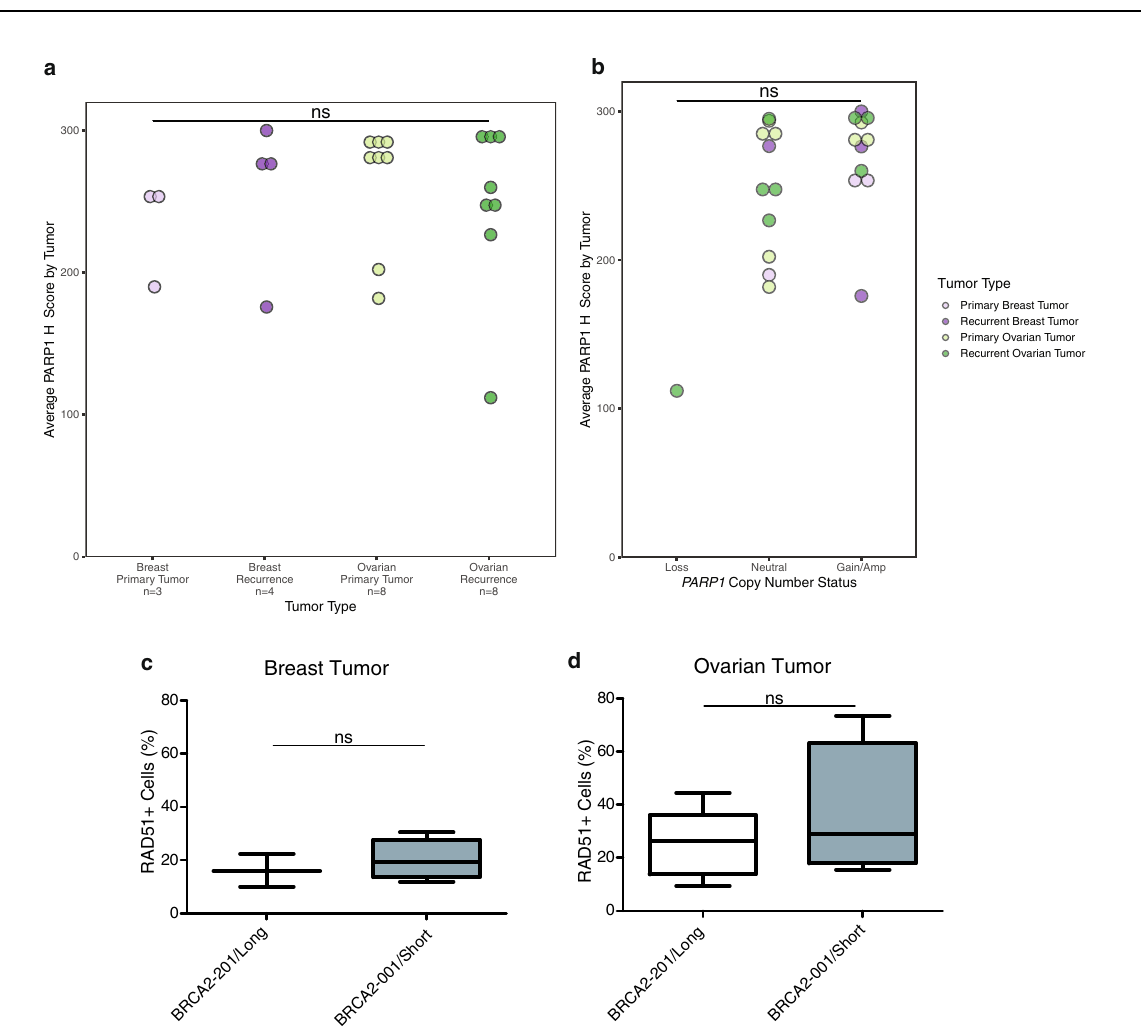
Fig. 4 | Gene fusions and isoform switching detected by RNA sequencing. a Clinical characteristics of patients in which IGH-@, IGL-@ , and MALAT1 fusions were identi fi ed. Tumors are displayed in chronological order by patient, with the primary tumor atthe top and latestrecurrenceatthe bottom. “ 1 fusion ” refersto a translocation with one other gene. LOH BRCA1/2 allele-speci fi c loss of hetero- zygosity;PARPiPARPinhibitor. b Exampleof MALAT1-IGH-@ genefusionIGVtracks from patient 9. Junction reads (red, middle track) represent split RNA-seq reads usedtomapthefusionbreakpoint.Spanningreads(black,bottomtrack)represent paired-end reads of fragments that span, but do not directly overlap, the fusion breakpoint. c Expression of total BRCA2 (all isoforms) in recurrences vs. normal samples ( n =66 biologically independent samples from 39 patients). Data are expressed as mean values +/ – SD. NS not signi fi cant. Adjusted p -values were